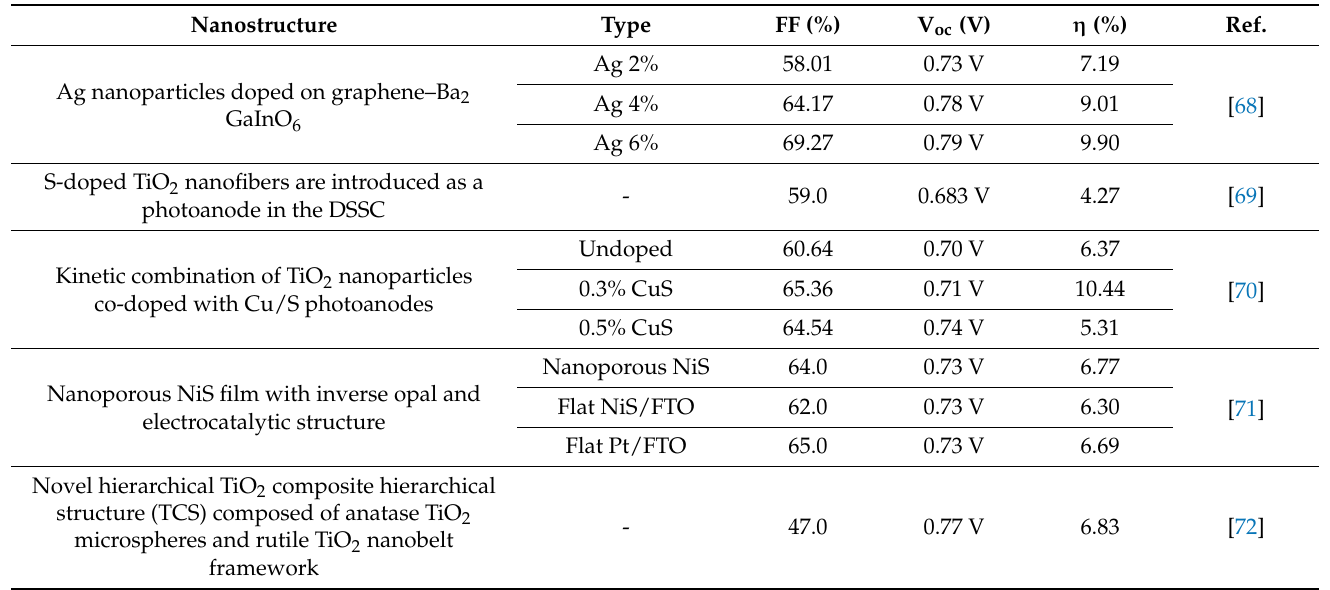
Table 7. Novel nanostructures reported for